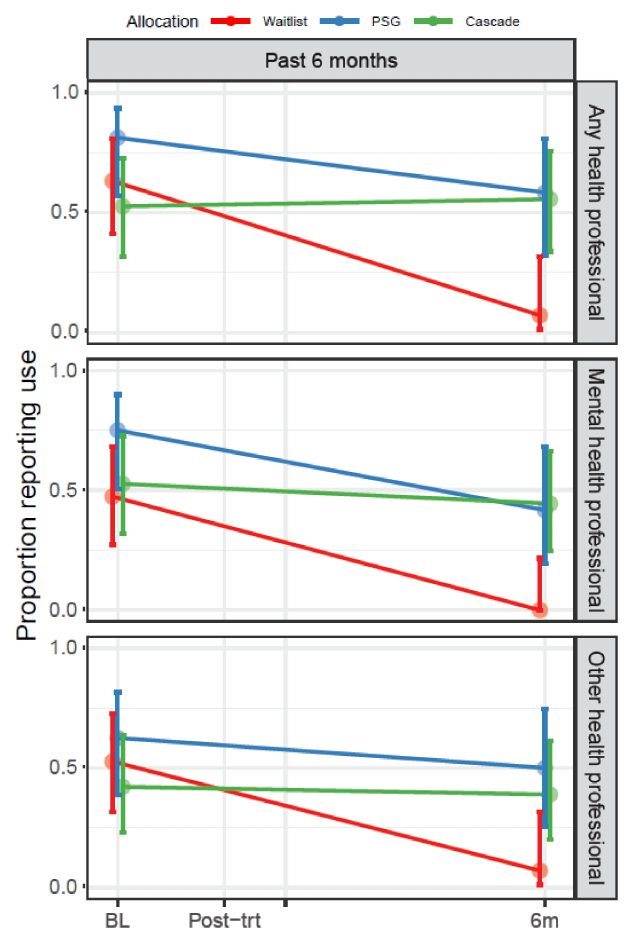
Figure 6. Proportion of parents who accessed any mental health professional or other health profes- sional in the last six months, at baseline (Q1) and six months post-intervention (Q4). Notes: Mental health services included visiting a psychologist, social worker, counselor, or psychiatrist, as well as community-based cancer support organizations. Other health service use included visiting a general practitioner (family doctor), oncologist/radiation oncologist, nurse in hospital, or nurse in the com- munity. BL: Baseline (Q1); Post-trt (Q2): After intervention; 6m: Six months after intervention